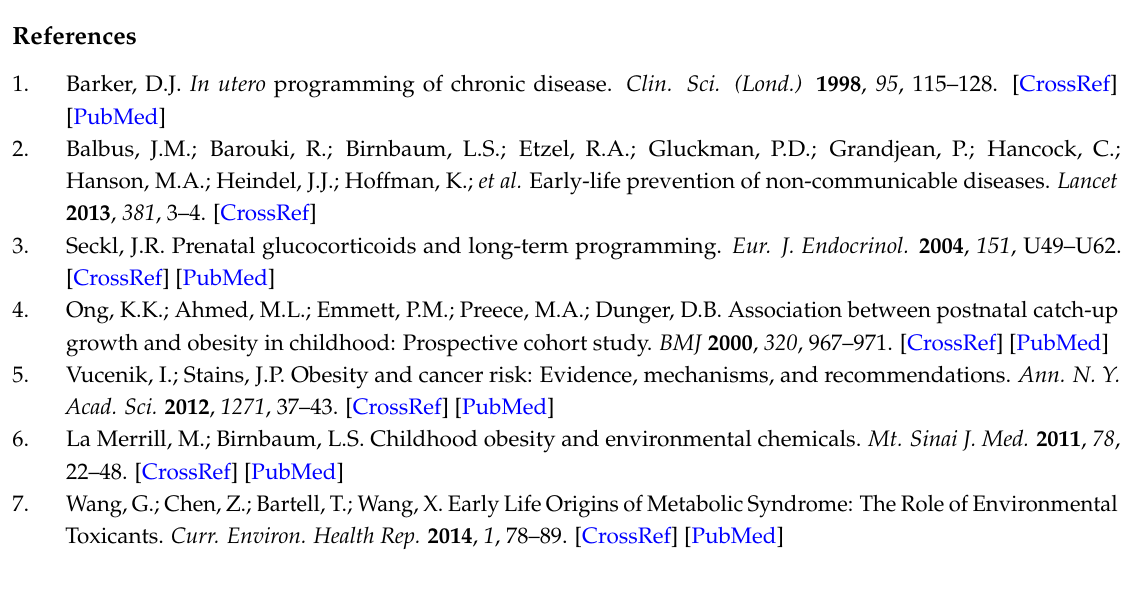
Table S1: Pearson correlation matrix of the exposure data. Table S2: Results of the Principal Component Analysis (PCA): component loading weights for the exposures. Table S3: Mixture regression models with significant negative associations between maternal exposure and birth weight. Table S4: Mixture regression models with significant negative associations between maternal exposure and birth weight in girls but not in boys. Table S5: Mixture regression models with significant negative associations between maternal exposure and birth weight in boys but not in